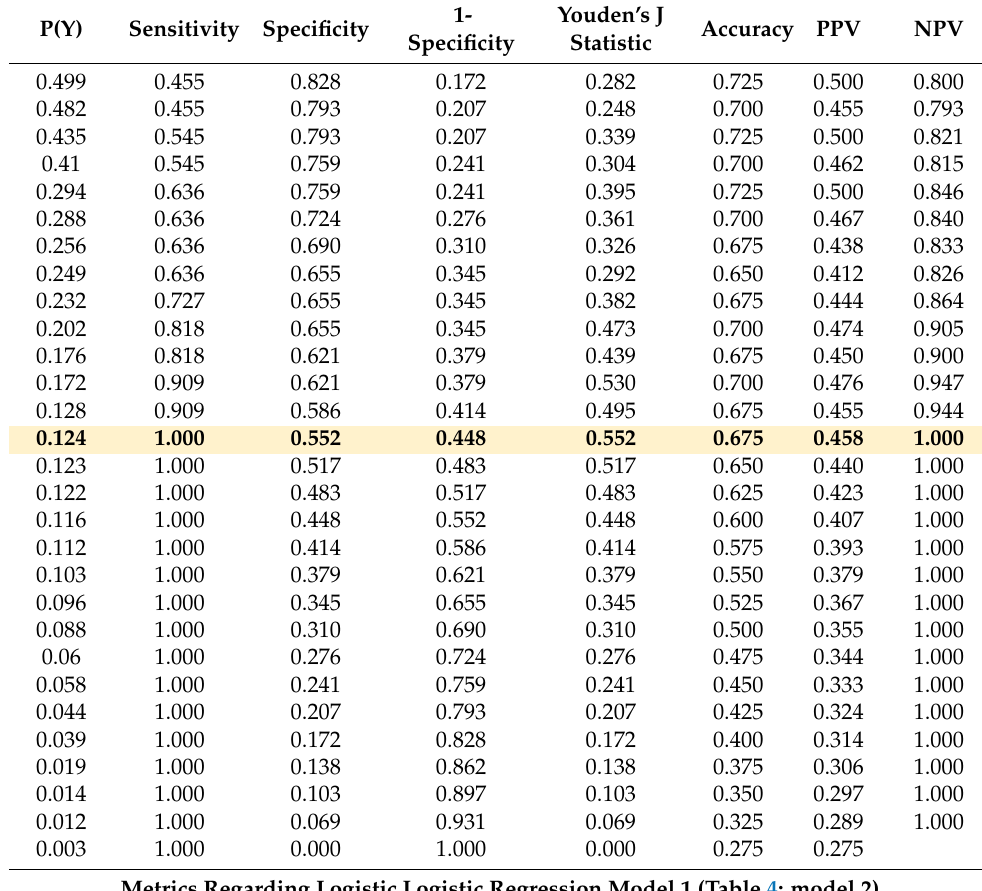
Table A4. Cont. Metrics Regarding Logistic Logistic Regression Model 1 (Table 4: Model